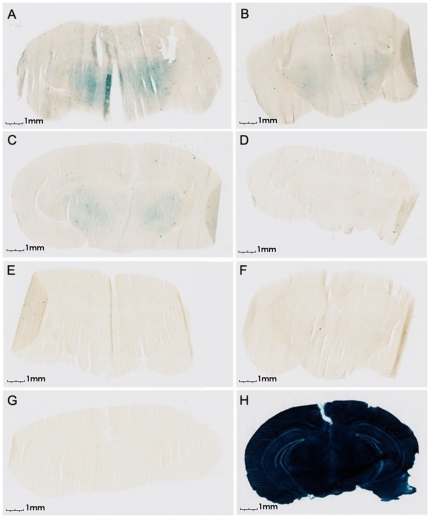
Evaluation of the integrity of the BBB after injection of K16ApoE.Separate mouse (represented by A through G) all received an injection of K16ApoE, followed by injection of beta-galactosidase at indicated times. Brain slices were made 6 h after beta-galactosidase injection and proceeded with staining for activity of the enzyme. A – Beta-galactosidase was injected 1 min after K16ApoE injection. B – Beta-galactosidase was injected 5 min after K16ApoE injection. C – Beta-galactosidase was injected 10 min after K16ApoE injection. D – Beta-galactosidase was injected 30 min after K16ApoE injection. E – Beta-galactosidase was injected 1 h after K16ApoE injection. F – Beta-galactosidase was injected 2 h after K16ApoE injection. G – Beta-galactosidase was injected 4 h after K16ApoE injection. H- positive control (beta-galactosidase mixed with K16ApoE was injected, brain slices were made 4 h after the injection and stained for enzyme activity.